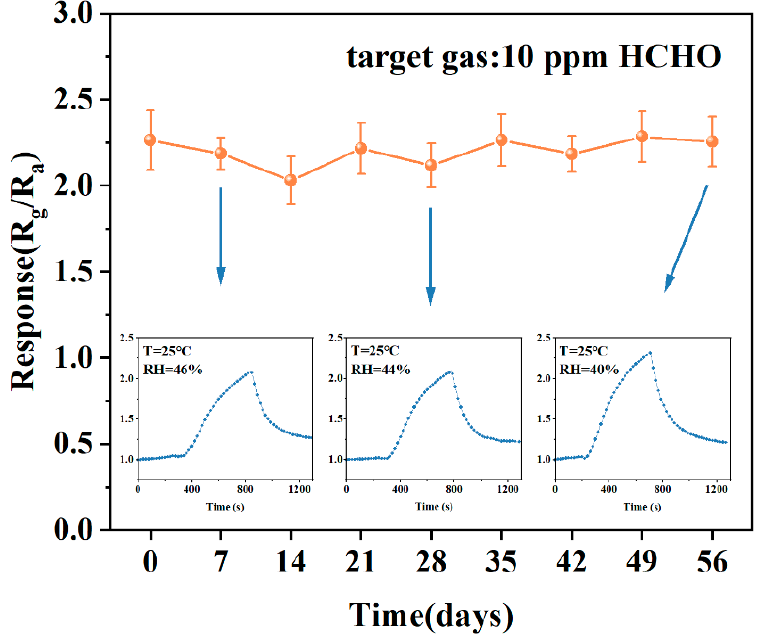
Figure 9. Long-term stability of the MXene/NiO-P2 sensor to 10 ppm HCHO for about 56 days at 25 °C. Table 1. Comparison of the performance of the sensors proposed in this work with previously re- ported sensors for HCHO detection.